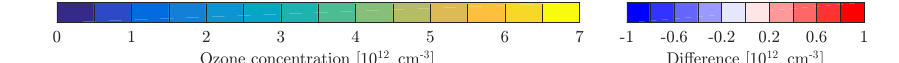
for 4 years in between. To demonstrate this more clearly, the scatter plot in Fig. 8 shows daily averaged ozone columns of SWIFT on the x axis vs. the ones from ATLAS on the y